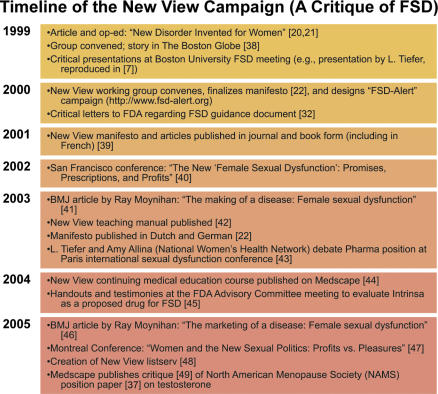
Timeline of Events Beginning in 1999 of Activism, Which Came to Be Called the “Campaign for a New View of Women's Sexual Problems”(Figure: Rusty Howson)